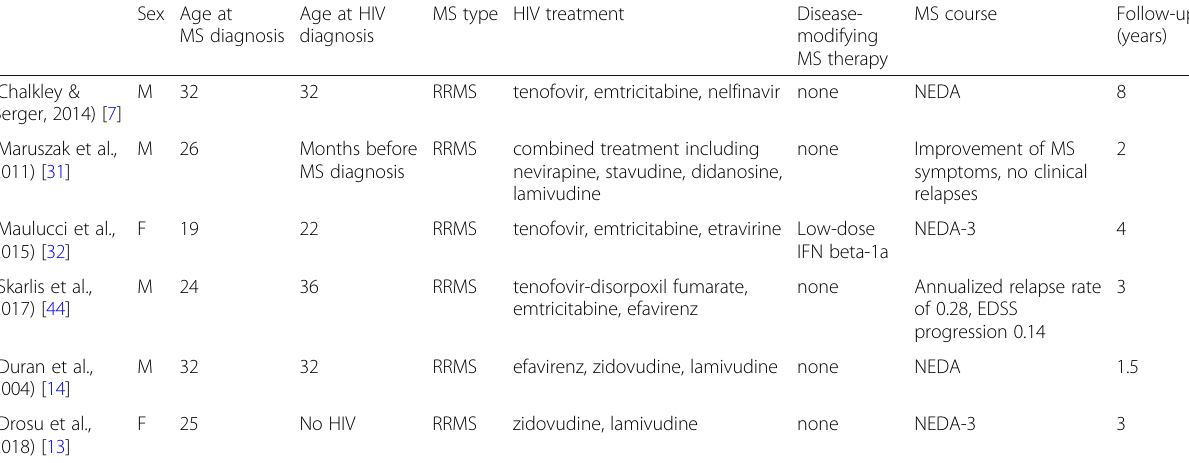
Table 1 Clinical characteristics of reported MS patients (with or without HIV infection) treated with antiretroviral medication Sex Age at Age at HIV MS diagnosis